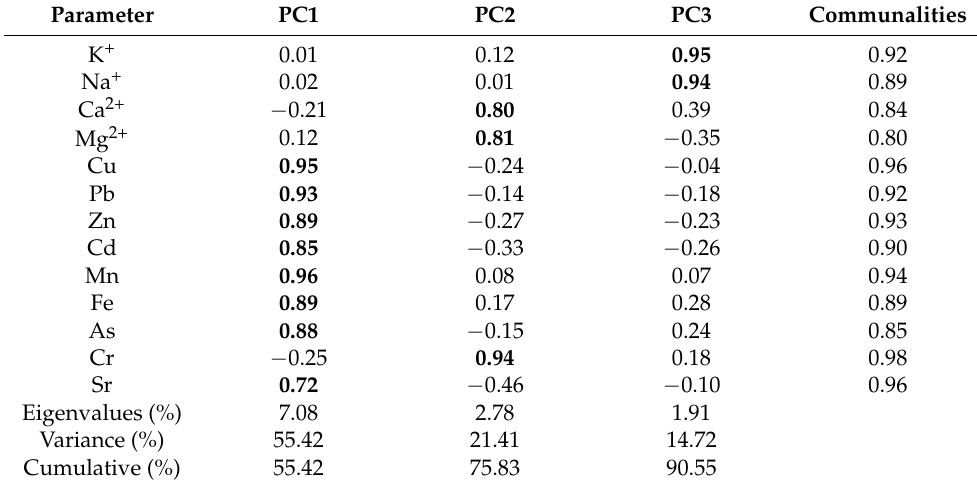
Table 3. Pearson correlation matrix of heavy metals in the Sidi River’s karst basin.